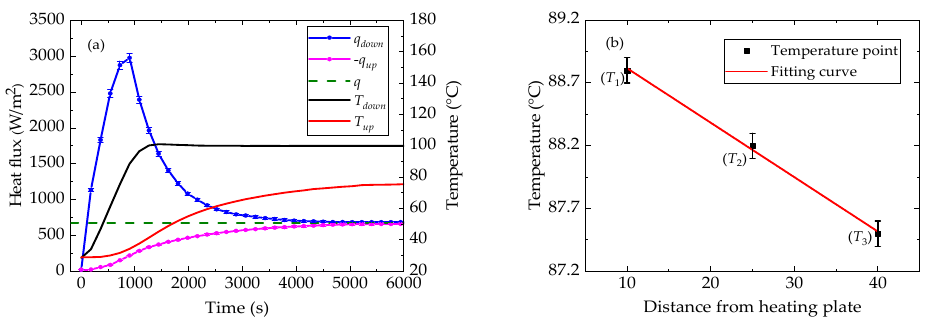
Figure 5. Results of heat fluxes and temperatures in the calibration when the heating temperature was 100 °C. ( a ) Curves of heat flux and temperature measurements. ( b ) Temperature gradient in the material. Therefore, thecontactthermalresistancesofbothplatesareexpressedbyEquation(19)andEquation(20).